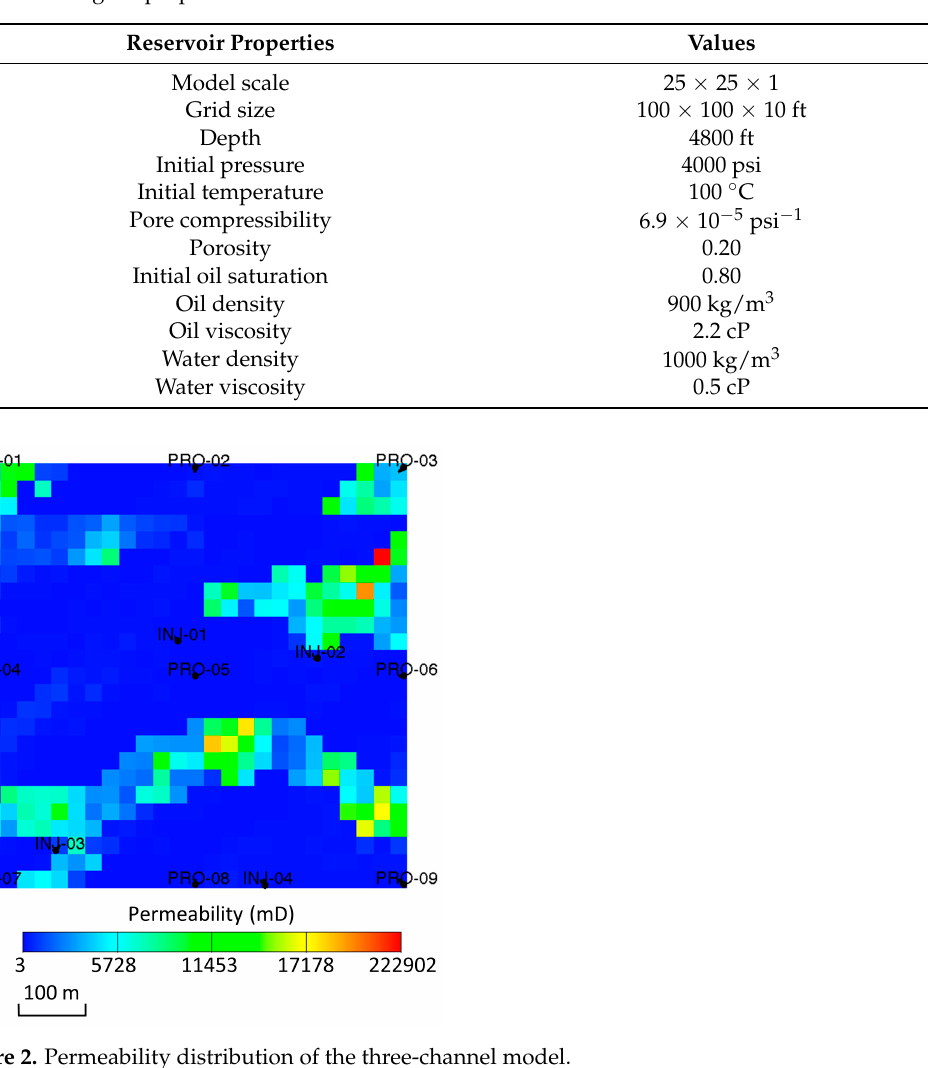
Table 2. Geological properties of the three-channel model.